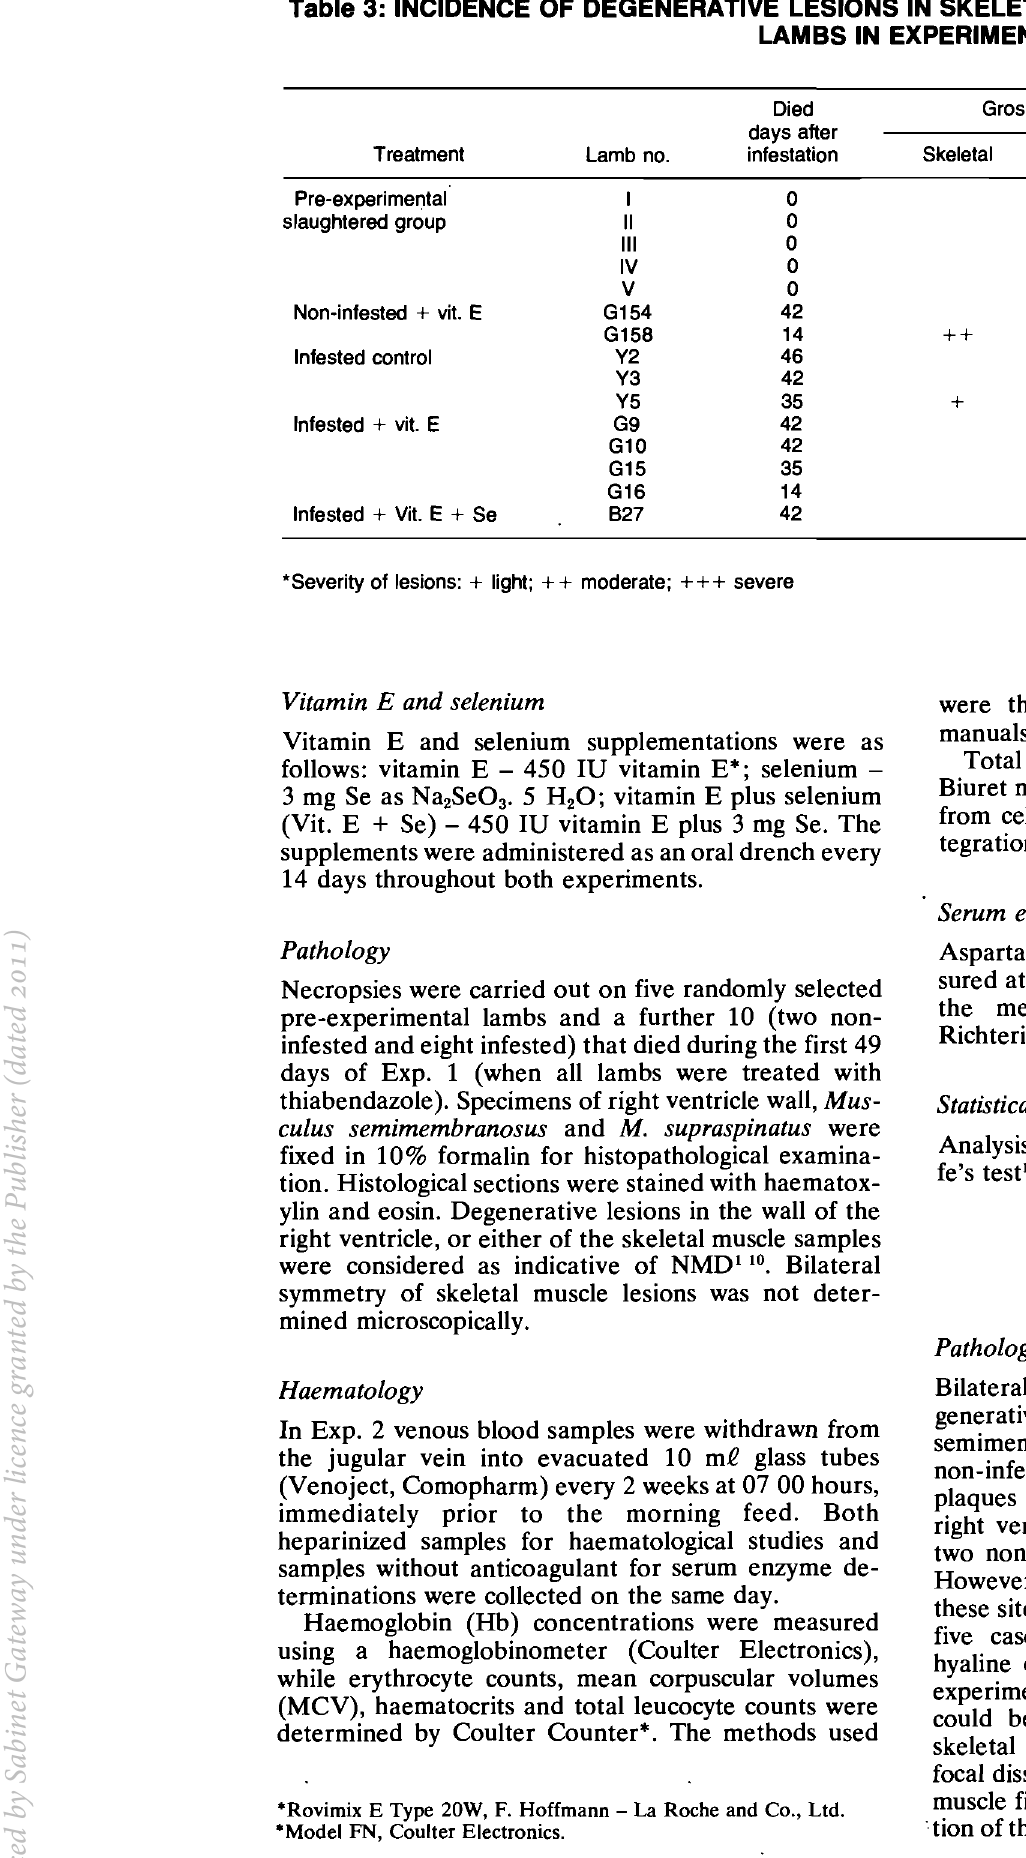
Table 3: INCIDENCE OF DEGENERATIVE LESIONS IN SKELETAL AND CARDIAC MUSCULATURE